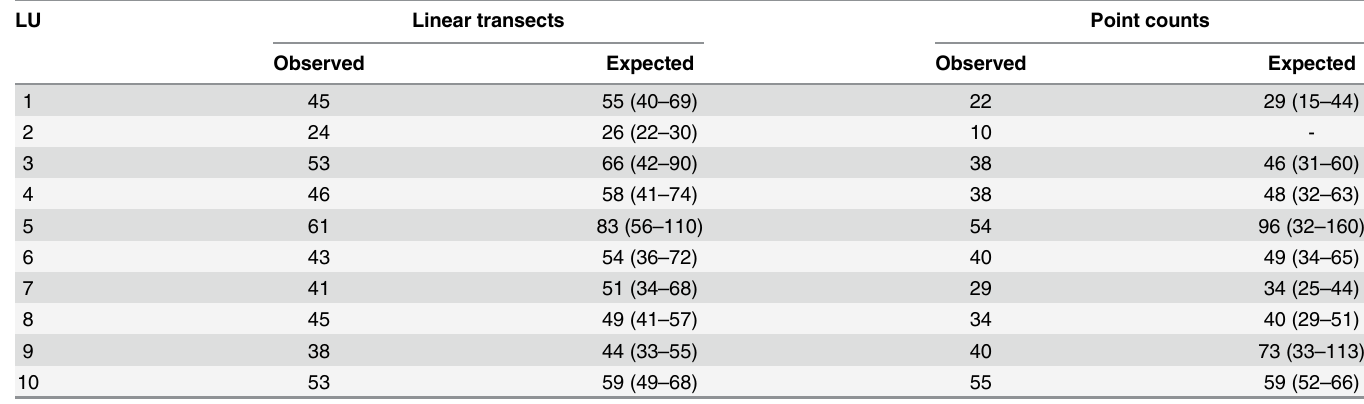
Table 2. Observed and expected species number (95% confidence intervals) of each LU obtained by non parametric Chao Index.